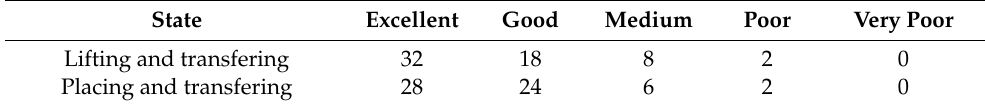
Table 1. Evaluation results of the